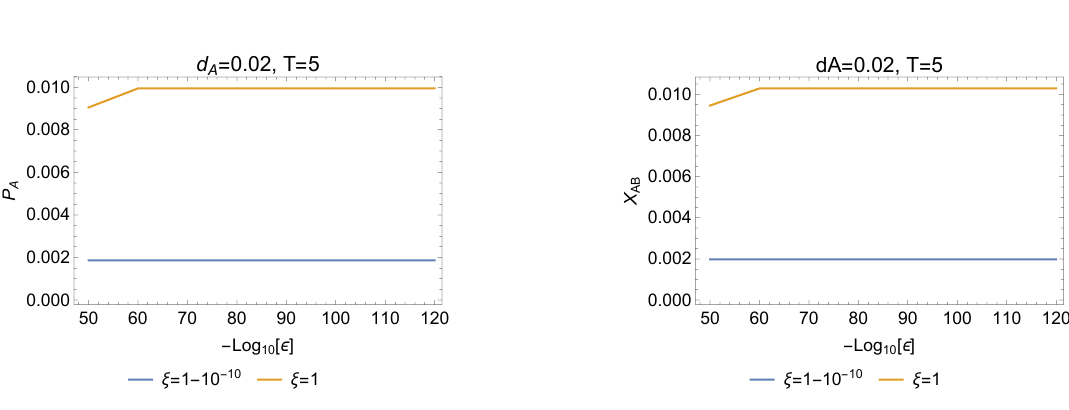
Figure 7 . Linear increase in P and j X j for (cid:24) = 1. The parameters used here are (cid:20) = (cid:10) = 50, d A = 0 : 01 and (cid:1) x = 0 : 05.